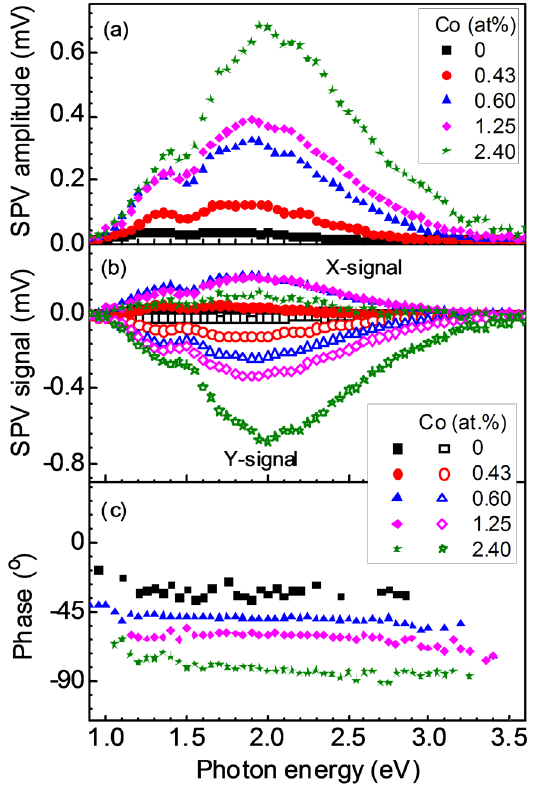
Figure 2. ( a ) Modulated surface photovoltage (SPV) amplitude; ( b ) X- and Y- signals; and ( c ) phase angles for TiO 2 and CTO thin films with Co dopant concentrations of 0.43, 0.60, 1.25, and 2.40 at %.